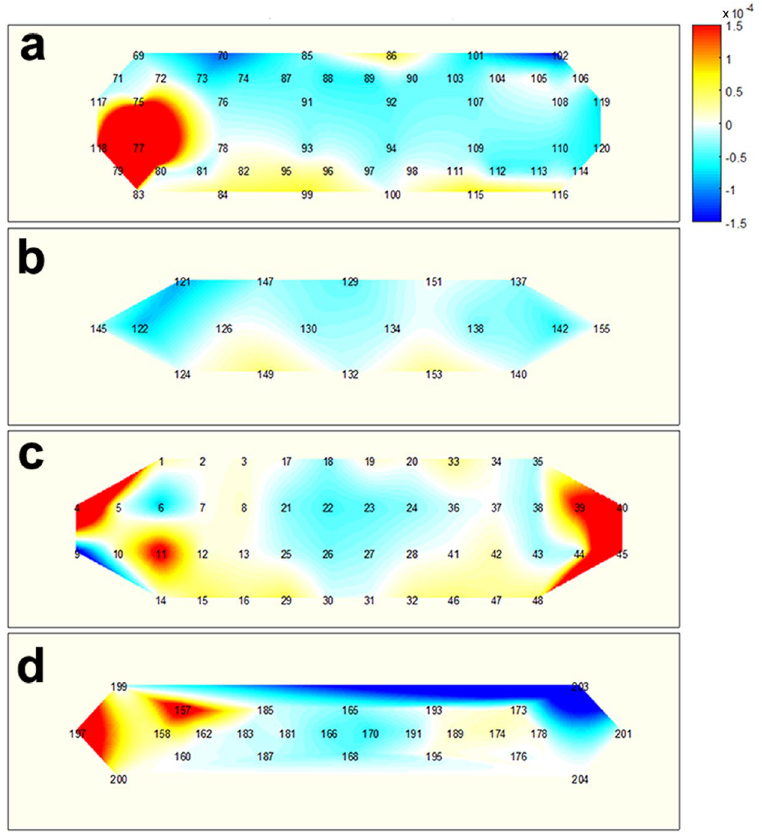
Figure 6. Hemodynamic variations ( Δ HbO) induced by BL and measured by using four SD separations 15 s after task onset: ( a ) 15 mm, ( b ) 21.2 mm, ( c ) 30 mm, and ( d ) 33.5 mm. The numbers in each subfigure denote the locations of NIRS channels. The vertical colour bar indicates the range in